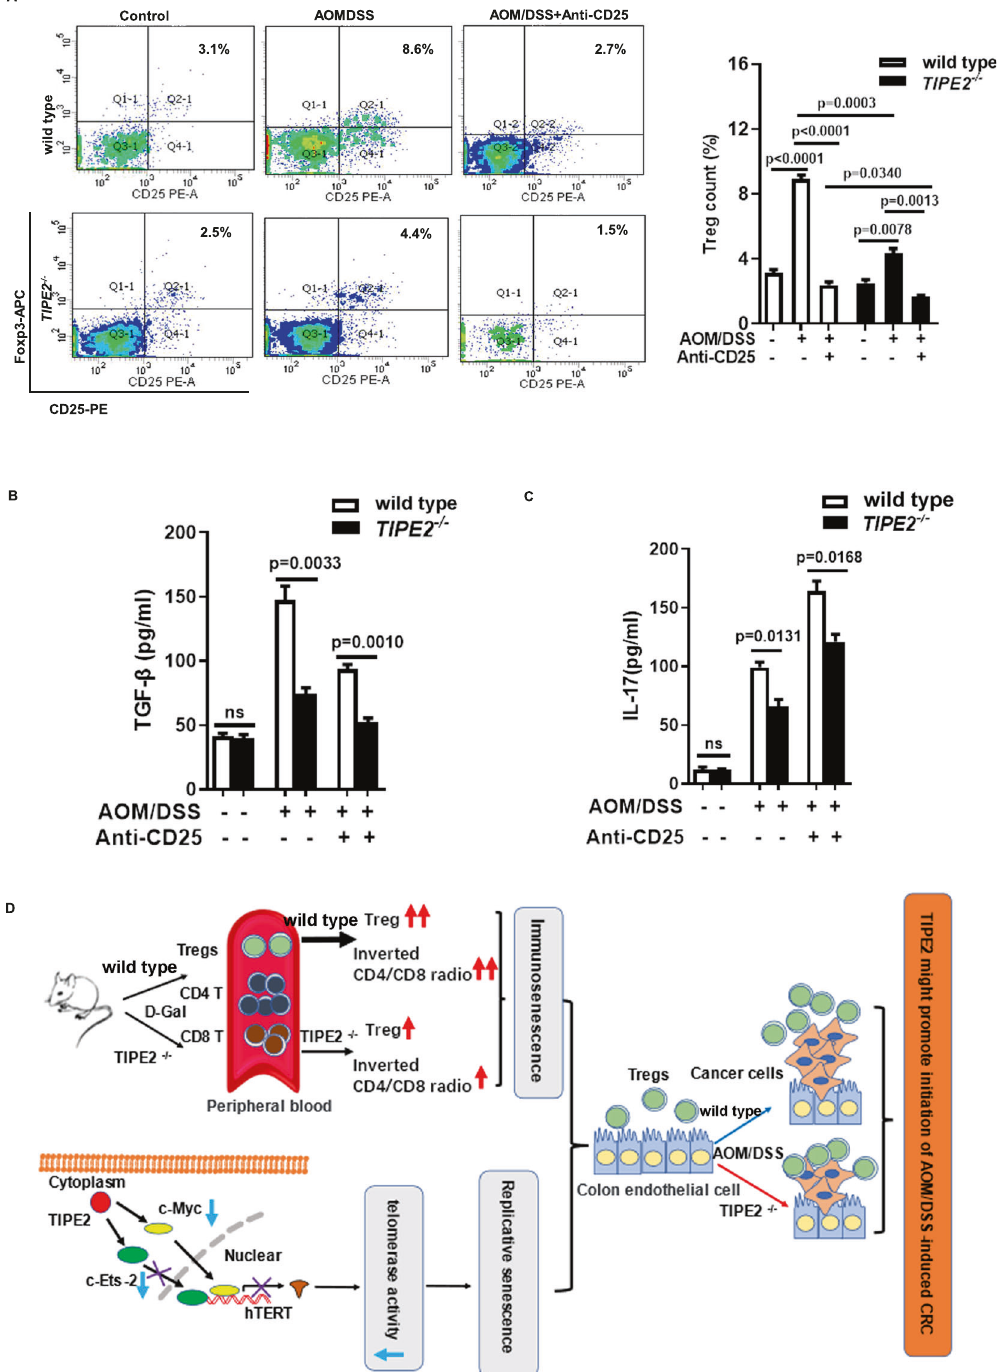
Fig. 7 Cytokines detection and probable mechanism. A The percentage of Tregs from IEL separated from Tipe2 -de fi enct AOM/DSS models was signi fi cant lower than WT controls, especially with anti-CD25 treatment. Data were collected using BECKMAN COULTER CytoFLEXS, then analyzed using CytExpert. Tipe2 -de fi cent AOM/DSS models showed lower serum levels of TGF- β ( B ) and IL-17 ( C ) with or without anti-CD25 antibody treatment. D Tipe2 inhibits tumor cell growth while promotes the initiation of AOM/DSS-induced colon cancer through regulating